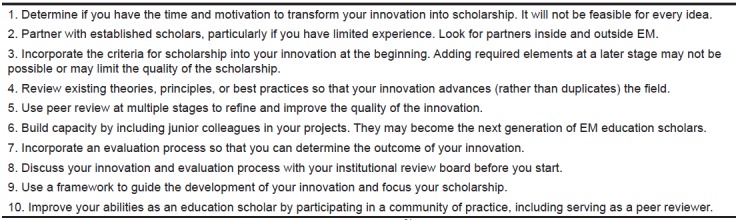
Key steps to transform an education innovation into scholarship.24EM, emergency medicine